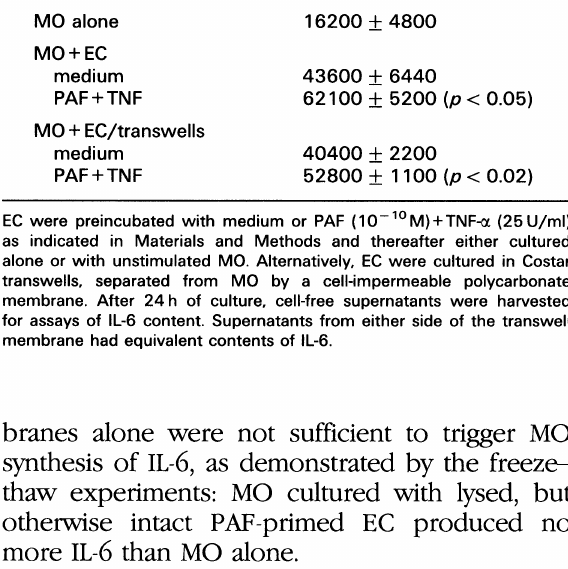
___ ___ _ ___ 50 400 5200 (p < 0.05) 2200